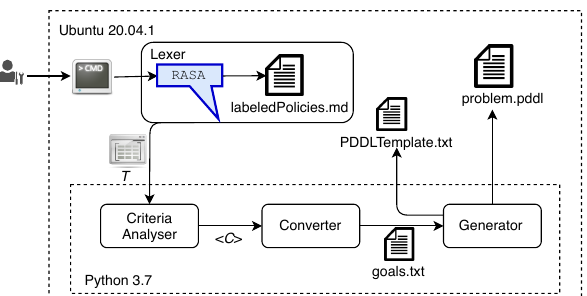
Figure 8. NORA prototype.